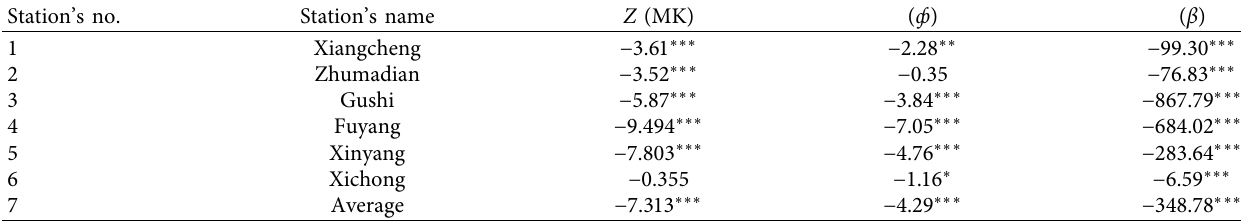
Table 4: Z-statistic results of MK, ITA ( ф ), and Sen’s slope estimator test ( β ). Station’s no.